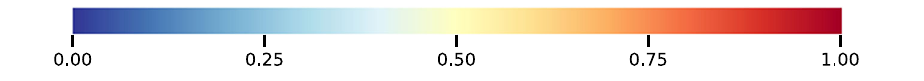
Fig. 5 CD8 + T cell states with respect to the insulin resistance pathway identi fi ed by attractor analysis with scBONITA. a UMAP representation of a cluster of CD8 + T cells (CD8 + T cells – 1 in Fig. 1a) colored by the attractor to which they are assigned, based on their similarity. The three dominant states (PI3KR + PI3K + , TNFR1 + TNF − , and TNFR1-TNF + attractors) are represented by green, blue, and orange. All other attractors are collectively labeled in gray. b Percentages of CD8 + T cells derived from each subject, mapping to the three dominant and all other attractors. c Gene activity (ON- red, OFF- light blue) in the three dominant attractors. Only genes that are different between these states are shown. d Attractor gene values ranging from 0 (blue) to 1 (red) averaged for each individual subject. The top bar indicates AS + (gray) and AS − (black) 27.4% of cells respectively (Fig. 5a, b). There is an association between attractors and subjects (chi-square test, p -value < 0.05) but no association between attractors and atherosclerosis status (chi-square test, p -value > 0.05). Additionally, we also performed attractor analysis for other cell clusters. Among those,